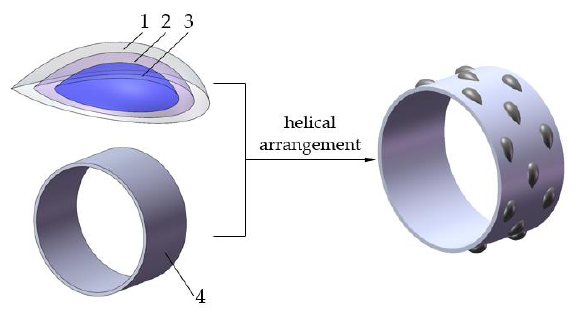
Figure 5. Structure diagram of lemniscate curve type press roller. 1. Gray convex hull (bulge height 14 mm); 2. Pink convex hull (bulge height: 11 mm); 3. Blue convex hull (bulge height 8 mm); 4. The smooth press roller (diameter in mm).